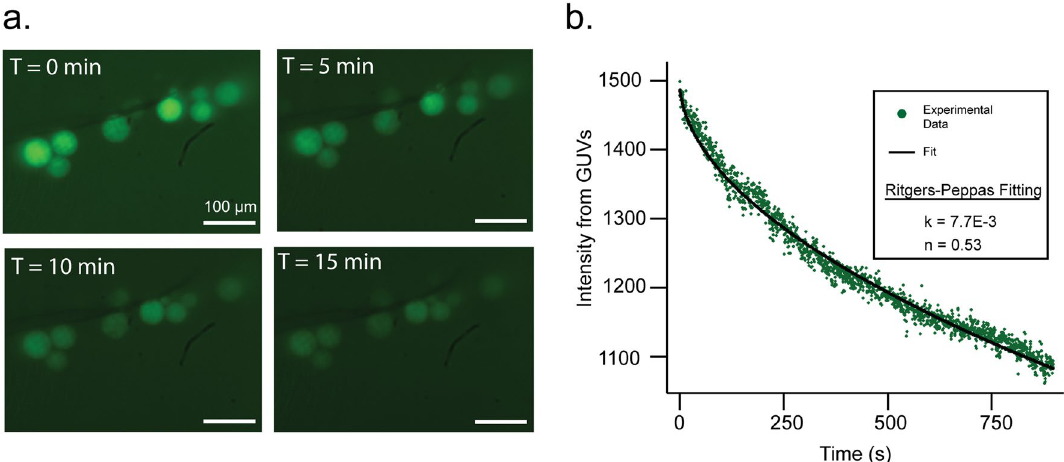
Figure 7. Real-time confocal images and analysis. ( a ) Fluorescence of FITC-dextran at different times of exposure to photoacoustic waves generated with a 10-Hz frequency from stationary GUVs, using CNT30- PDMS films. ( b ) Fluorescence intensity decrease from fits with the Ritger-Peppas equation for solute release, taking (1 − I t / I 0 ) as the fraction of drug release, where I t is the fluorescence at time t and I 0 the initial fluorescence, both corrected for background fluorescence. The laser fluence at the piezophotonic layer was 100 mJ/cm 2 , but interferograms show that the GUVs were exposed to ~ 1 MPa pressure